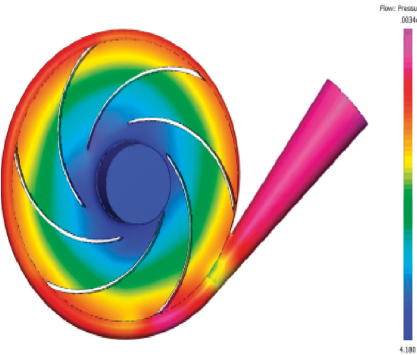
Figure 4: Pressure cloud diagram.